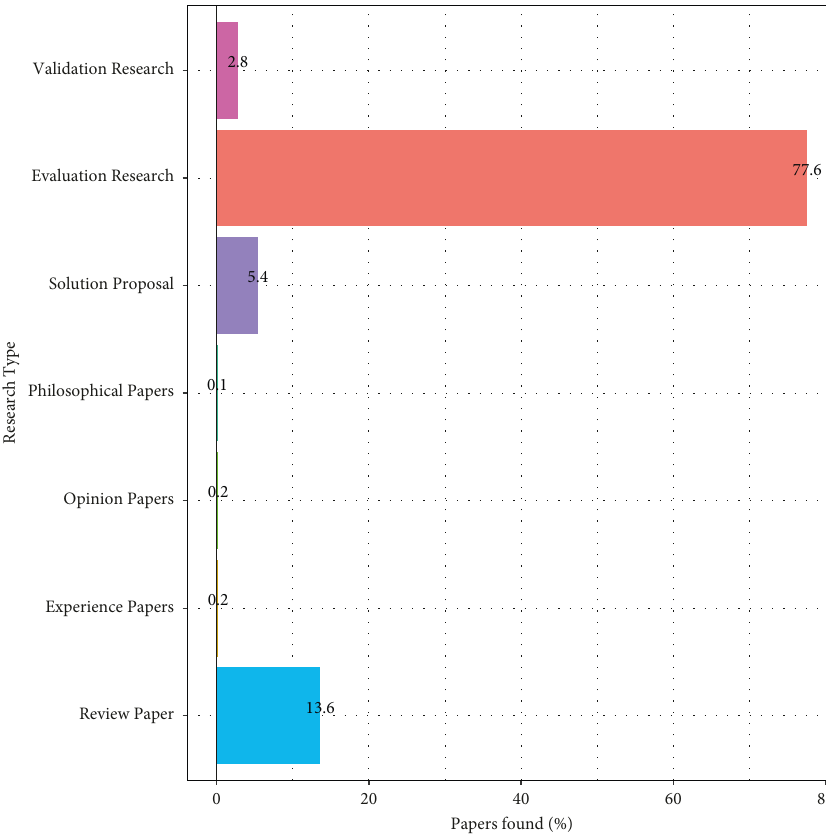
Figure 2: Percentage of the articles classified by research